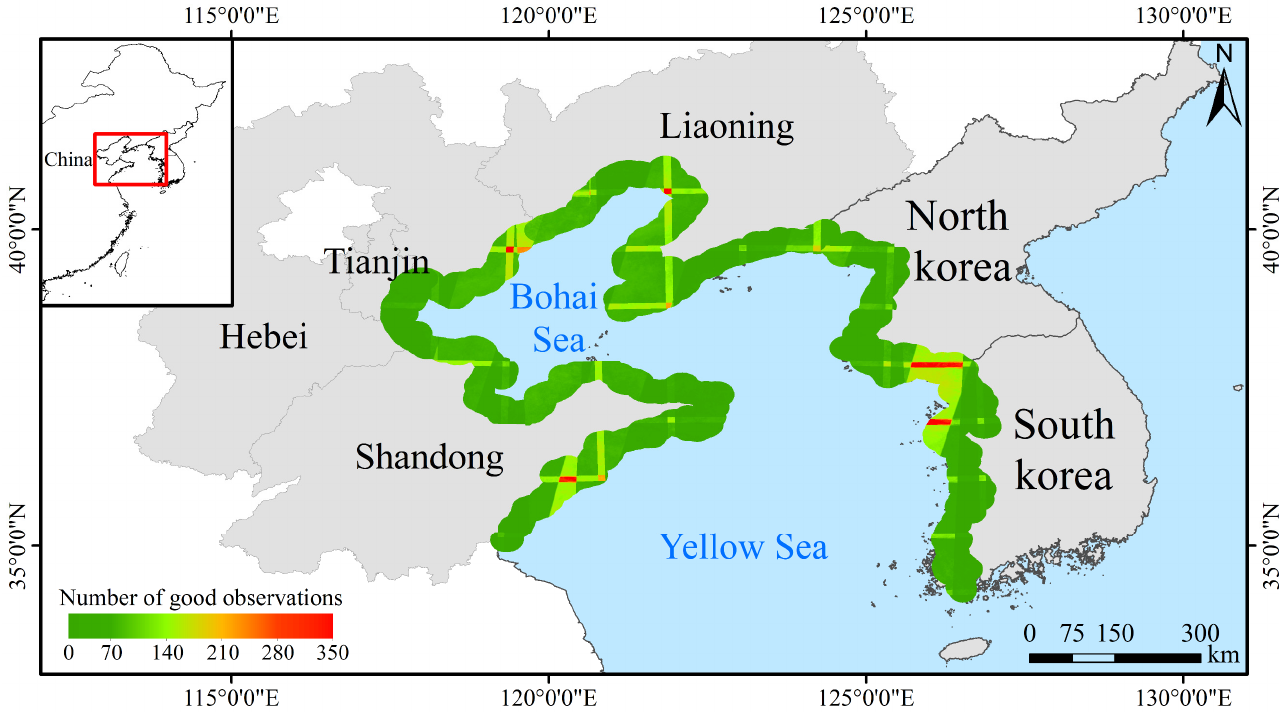
Figure 1. Location of the study area and the spatial distribution of Sentinel-2 good observation number. The accurate range of good observation number is 23 to 334. The top left red circle denotes the study area on a broader scale.